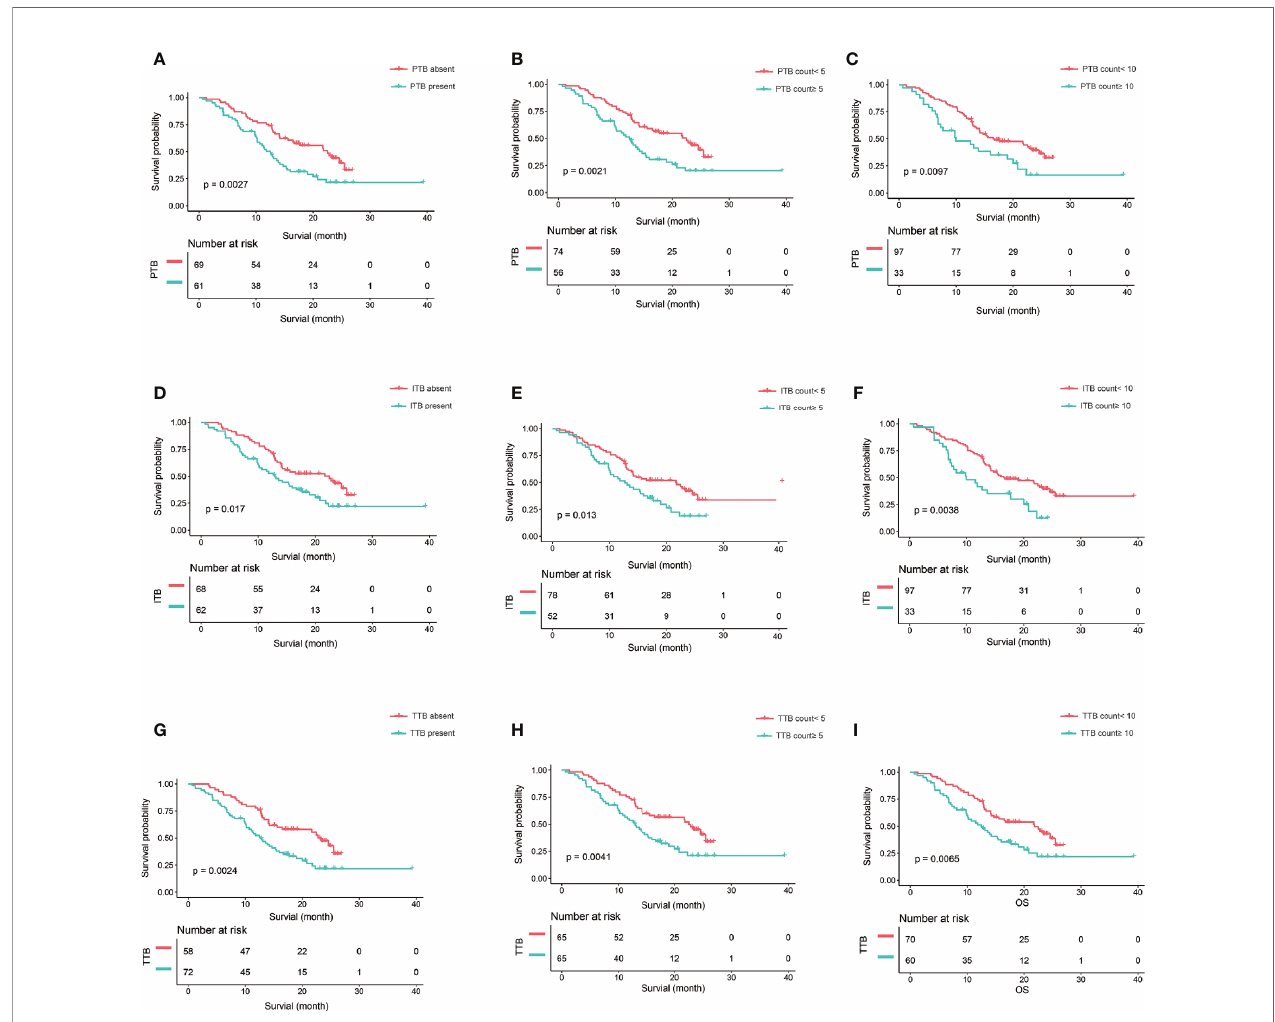
FIGURE 4 | The Kaplan-Meier curve and log-rank test. (A – C) The Kaplan-Meier curve and log-rank test suggest that patients in the PTB absent, PTB count<5, and PTB count<10 survived signi fi cantly longer than those in the PTB present, PTB count>5, and PTB count>10, respectively. (D – F) The Kaplan-Meier curve and log- rank test suggest that patients in the ITB absent, ITB count<5, and ITB count<10 survived signi fi cantly longer than those in the ITB present, ITB count>5, and ITB count>10, respectively. (G – I) The Kaplan-Meier curve and log-rank test suggest that patients in the TTB absent, TTB count<5, and TTB count<10 survived signi fi cantly longer than those in the TTB present, TTB count>5, and TTB count>10, respectively. PTB,, peritumoral budding; ITB, intratumoral budding; TTB, total tumor budding (PTB +